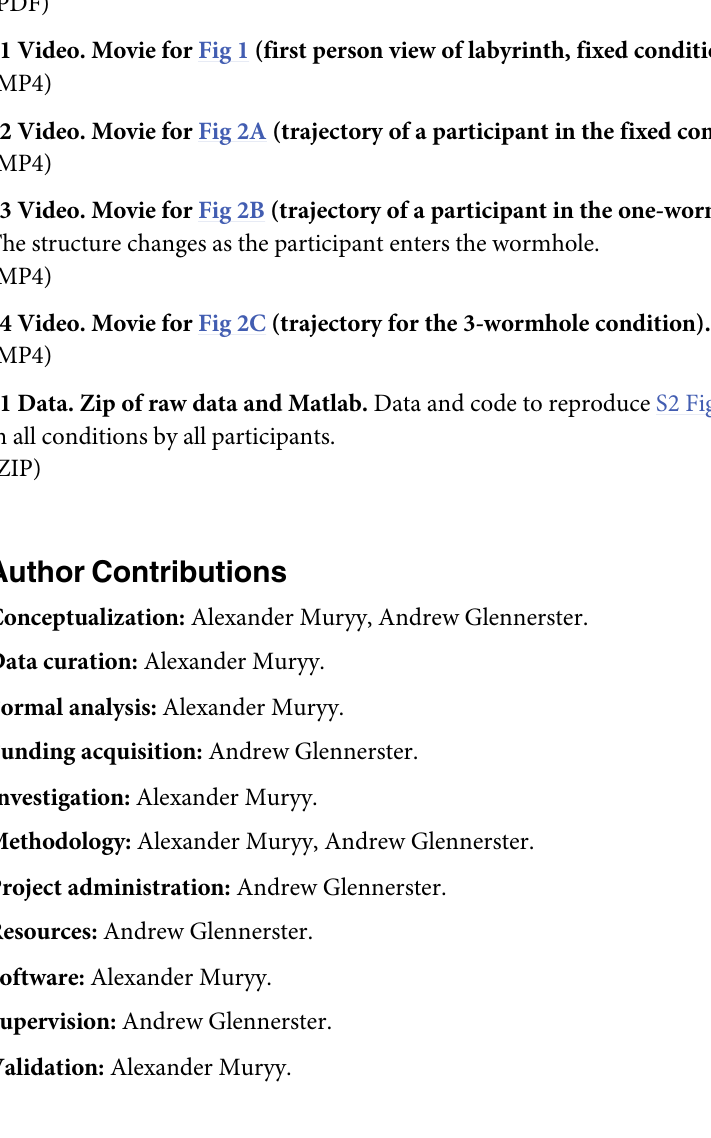
black lines indicate lengths of the shortest solution, measured along the middle of the corri- dors. During the 5 rounds of the learning phase, the task was always the same (go from Start to Red-Green-Blue-Yellow). During the test phase (last 3 rounds), participants were asked to solve novel tasks, i.e. the routes were different on every test round. S3 Fig. Sketches drawn by participants right after experimental session. The ground-truth schematics for both scenes in all conditions are shown in S1 Fig. (PDF) S4 Fig. Ability to point accurately against ability to find the shortest path. The x-axis shows a measure of the ability of participants to find shorter paths: it is a ratio of travelled distance during a full round to the shortest distance of that round. The y-axis shows the ability of partic- ipants to point accurately (from Muryy and Glennerster (2018)): this is a mean pointing error (degrees) per round (mean over 8 pointings, since at the end of a round participants pointed 8 times). Solid lines show fitted linear regression models.